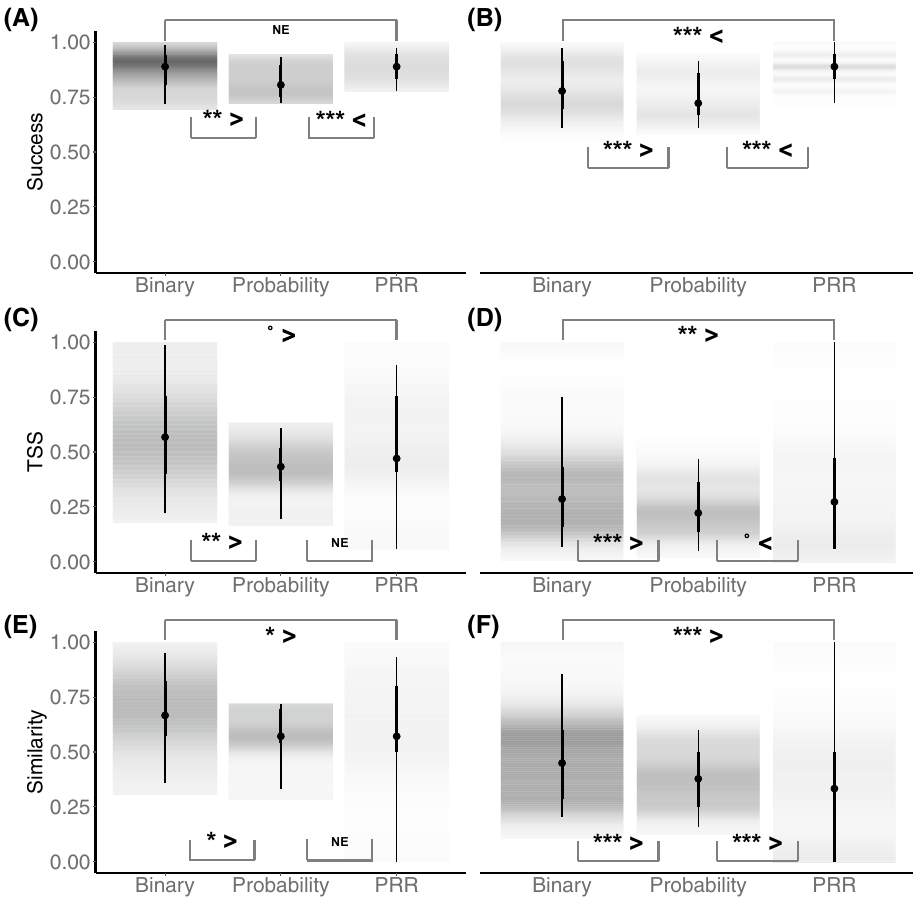
Figure 5. Accuracy of assemblage composition predictions at site and plot scales. Left panels ( A , C , E ) metrics at site scales and right panels ( B , D , E ) metrics at plot scale. Significant differences between stacking procedures (bS-SDM versus pS-SDM versus cS-SDM) were evaluated using Bayesian ANOVAs with NEON plot IDs as random effect (significance levels for the Maximum A Posteriori p-values are: ***p = 0, **p < 0.01, *p <